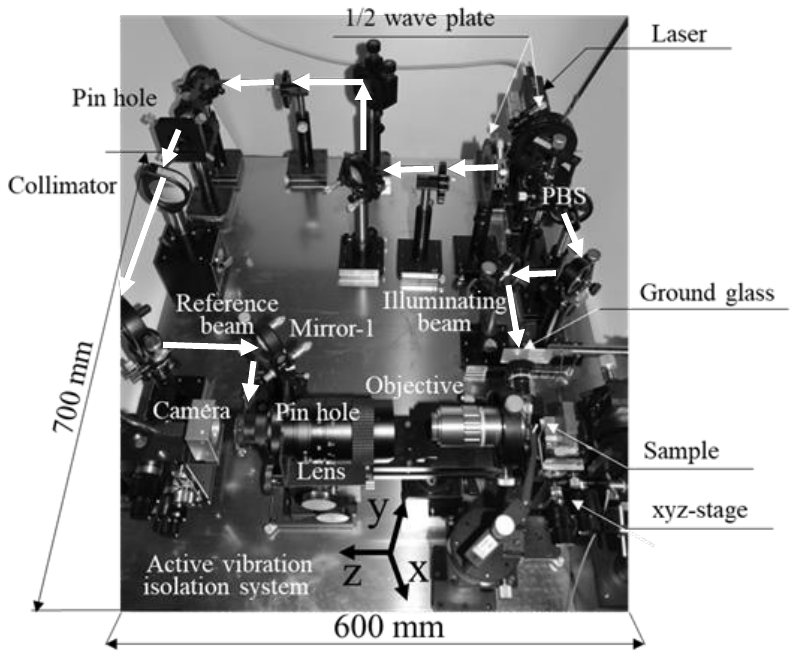
Figure 2. Optical system.